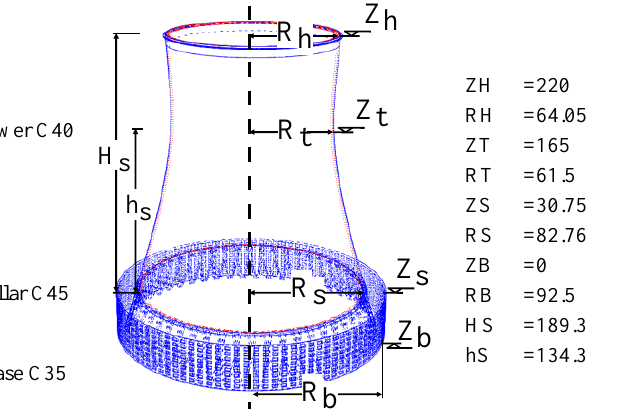
Figure 1. Schematic diagram of the main structural dimensions of the large cooling tower (units: m).